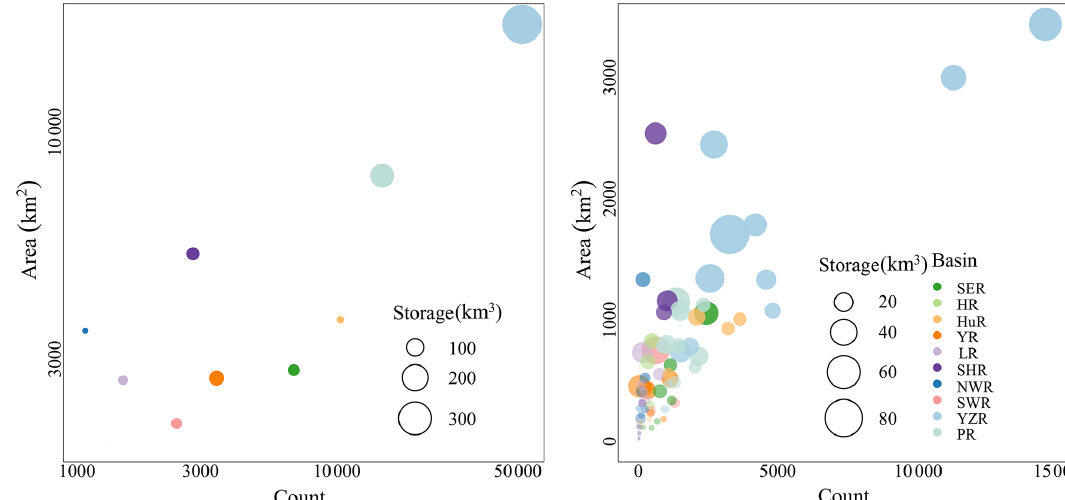
Figure 7. Bubble chart of reservoir count, area, and storage capacity of each basin in the first-level (a) and second-level (b) hydrologic basins. Different colors represent the 10 first-level basin units. Bubble size represents the size of reservoir capacity. Note: SER – Southeastern